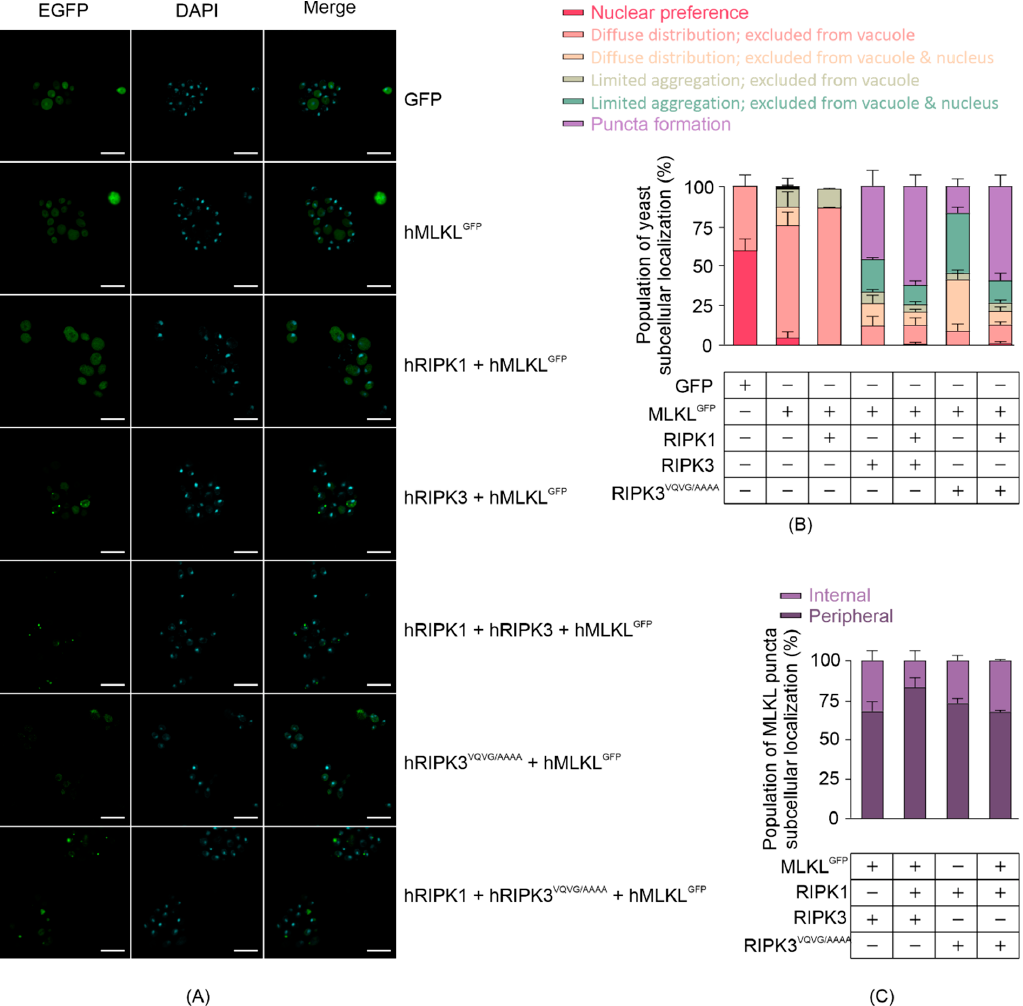
Figure 3. MLKL activation leads to its aggregation in yeast. ( A ) Subcellular distribution of C-terminal GFP-tagged MLKL in yeast after 24 h-induction in liquid media. Scale bars are 10 μ m. Quantitative analyses of ( B ) yeast populations in terms of the subcellular distribution of GFP-tagged MLKL, and ( C ) subcellular localization of MLKL GFP puncta in yeast were assessed by confocal microscopy. Yeast expressing GFP or GFP-tagged MLKL with or without RIPK1 and/or RIPK3 were grown in inducing media for 24 h. At least 35 cells per yeast culture were counted in each independent assay. Graphs present mean ± SEM of three independent assays.